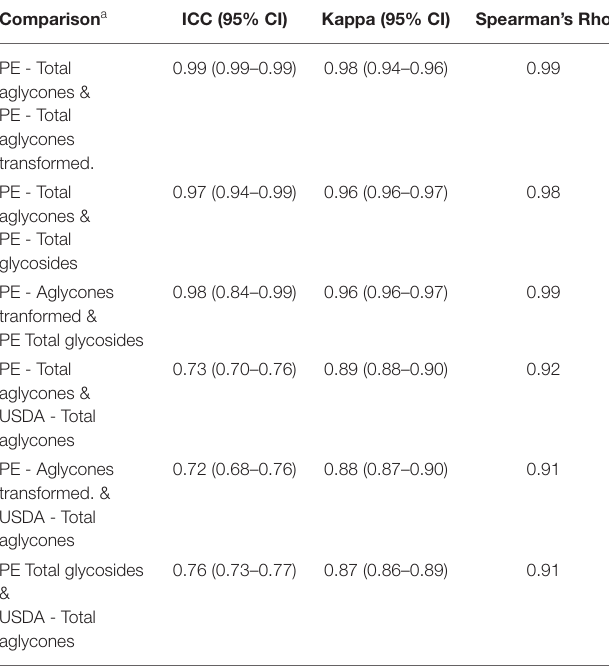
TABLE 4 | Degree of reliability and correlation in continuous and quintiles flavonoid intake estimations by databases and methods used. Comparison